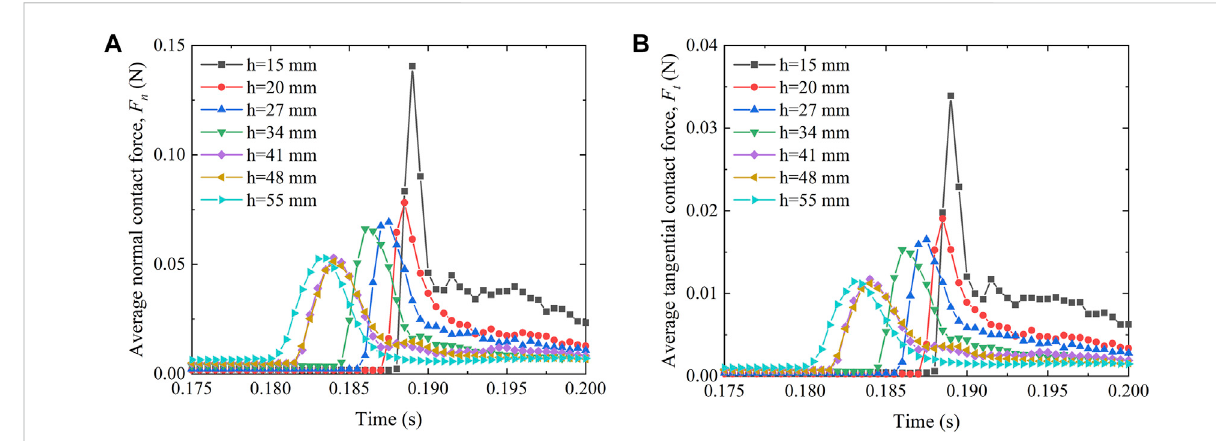
FIGURE 8 Evolutionofthecontactforcefortherockfallimpactingagainstthegranularmaterialofbuffering(sphere-cylinder)withdifferentthicknessesof the particle layer: (A) normal force; (B) tangential